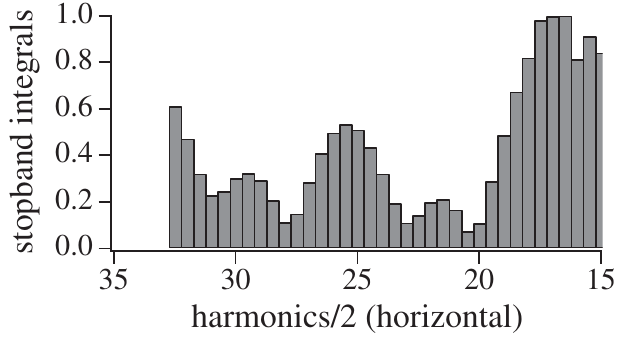
FIG. 11. Horizontal stopband integrals of a lattice with the same gradient errors as Fig.